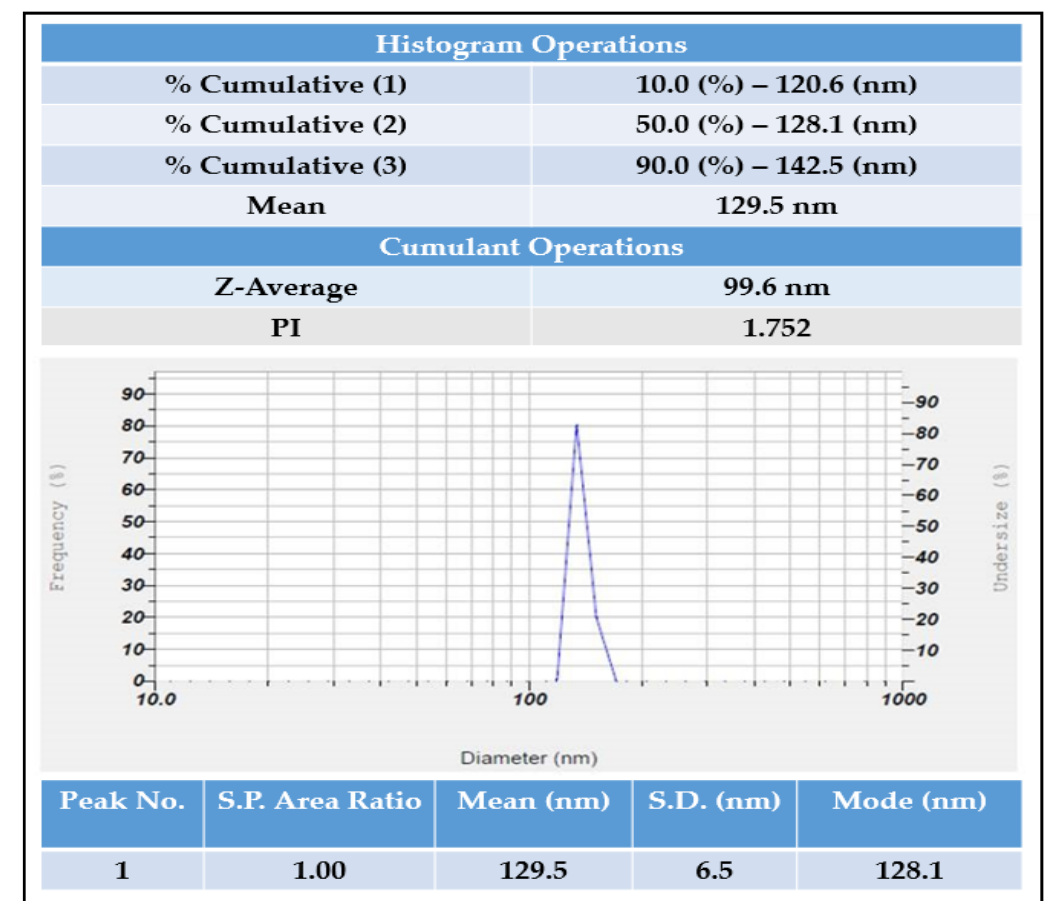
Figure 7. Zeta potential distribution of R. apiculata AgNPs.